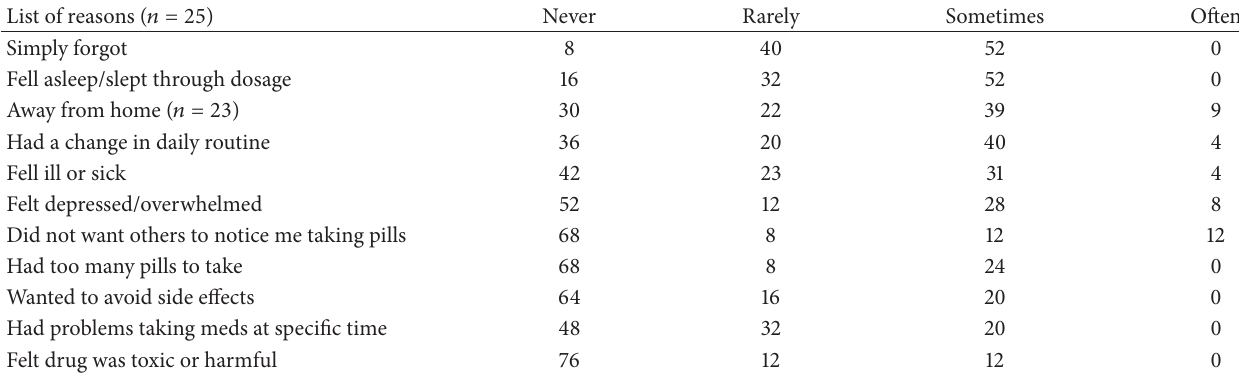
Table 3: Response to the AACTG Adherence Instrument among participants who reported ever missing a dose of HIV medication (expressed in